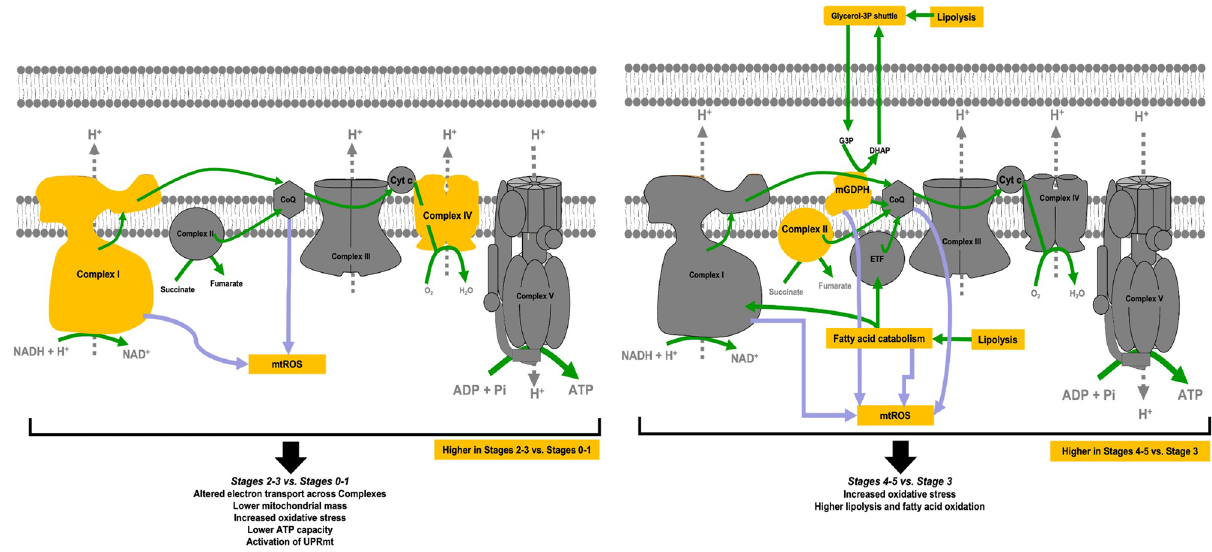
Figure 8. Bioenergetic differences across stages. Changes in bioenergetics (in yellow) that match the assignment of stages according to the decision tree classification (Fig. 2C). Altered Complex ratio and increased mitochondrial ROS characterized Stages 2–3 vs. Stages 0–1 (left panel), accompanied by lower mitochondrial mass (citrate synthase activity; see text). These changes result in an overall lower ATP production (altered Complex ratio and lower mitochondrial mass), and may activate the mitochondrial unfolded protein response (UPRmt). Higher fatty acid oxidation (Complex II, mGDPH) and mitochondrial ROS characterized Stages 4–5 vs. Stage 3. While these changes may increase ATP derived from mitochondrial fatty acid beta-oxidation, they may increase the susceptibility of neurons to hypoxic events and to ATP deficits as glucose catabolism is faster than that from fatty acids. Arrows in green indicate the electron flow and direction of biological processes; purple arrows indicate the ROS sources. CoQ coenzyme Q, Cyt c cytochrome c , Pi phosphate, mGDPH mitochondrial glycerophosphate dehydrogenase, ETF electron transfer flavoprotein, G3P glycerol-3-phosphate, DHAP